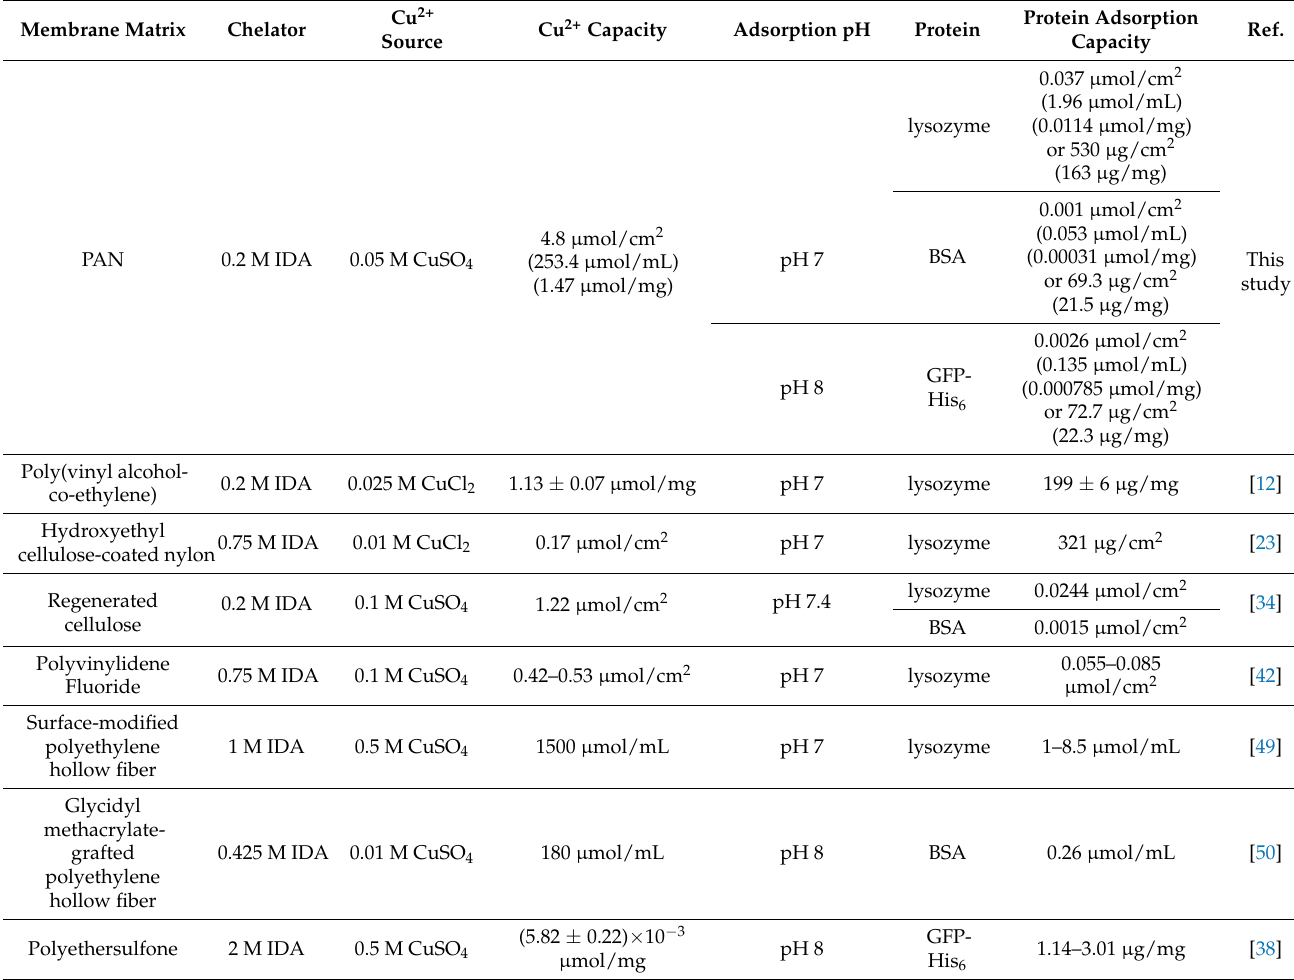
Table 2. The comparison of immobilized copper ion capacity and protein adsorption capacity obtained for the IMAM prepared in this study with the literature